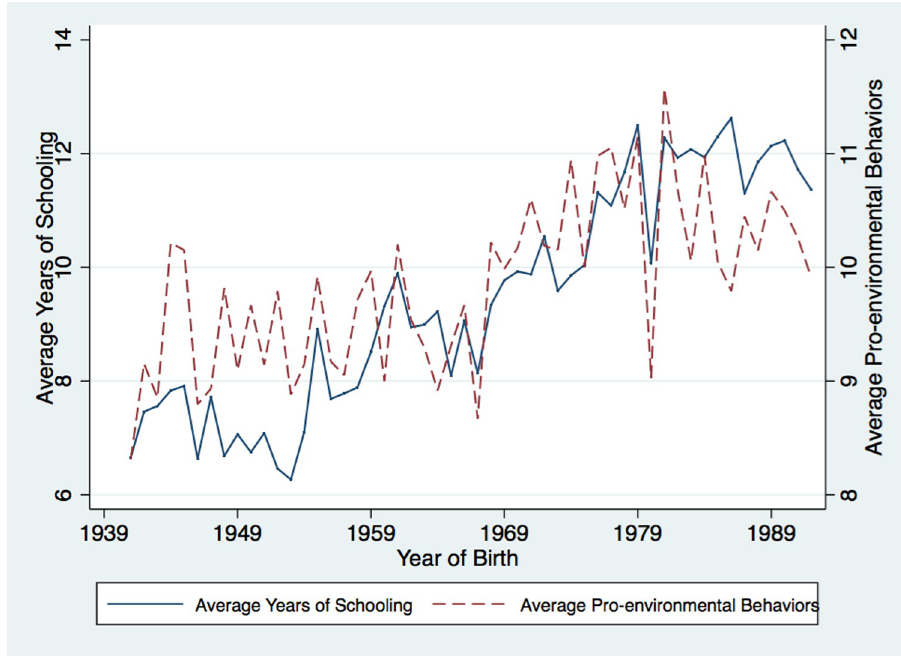
Fig 3. Average years of schooling and pro-environmental behaviors across year of birth. Note: This figure illustrates the relationships between education and pro-environmental behaviors across year of birth. The solid line represents the average years of schooling and the dashed lines represent the average pro-environmental behaviors. Data source is CGSS 2010.